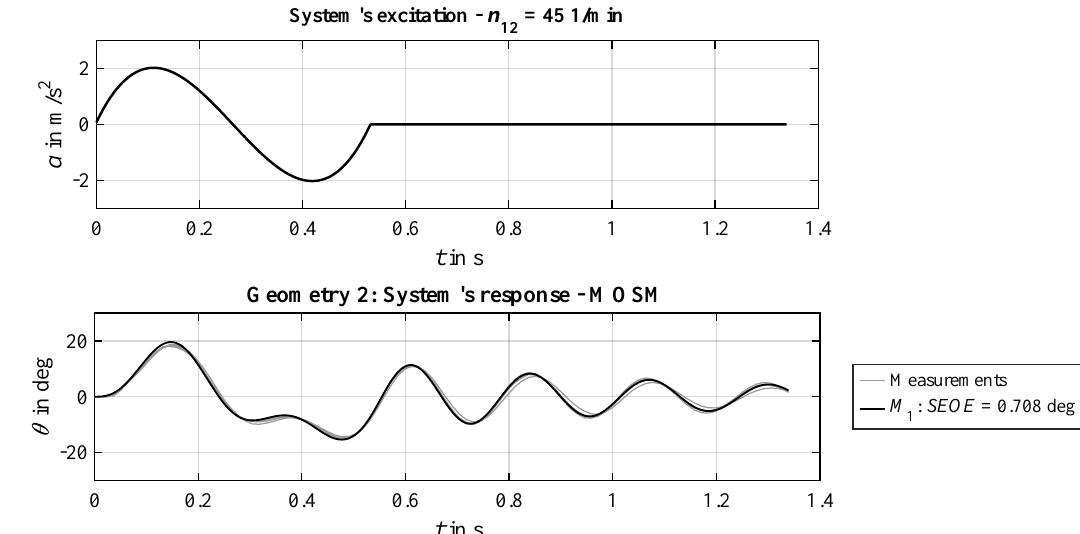
Figure 10. Exemplarily validation results and SEOE value displayed for geometry 2 and an operating speed of n = 451/min, applying the Multiple-Operating-Speed Model (MOSM) strategy and model approach M 1